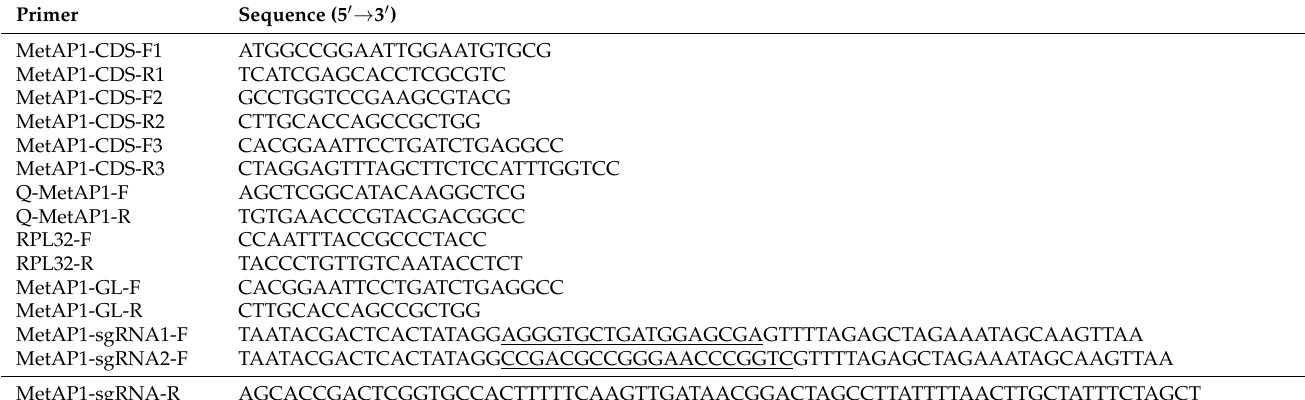
Table 1. The list of all primers of the PxMetAP1 gene in this